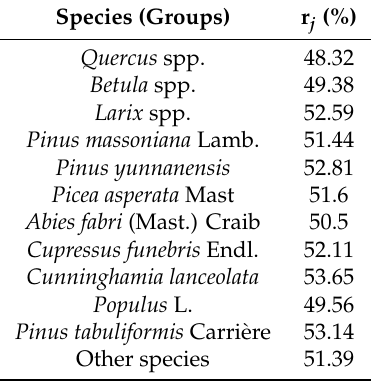
Table A3. Modeling parameter of Chinese tree species biomass carbon content.